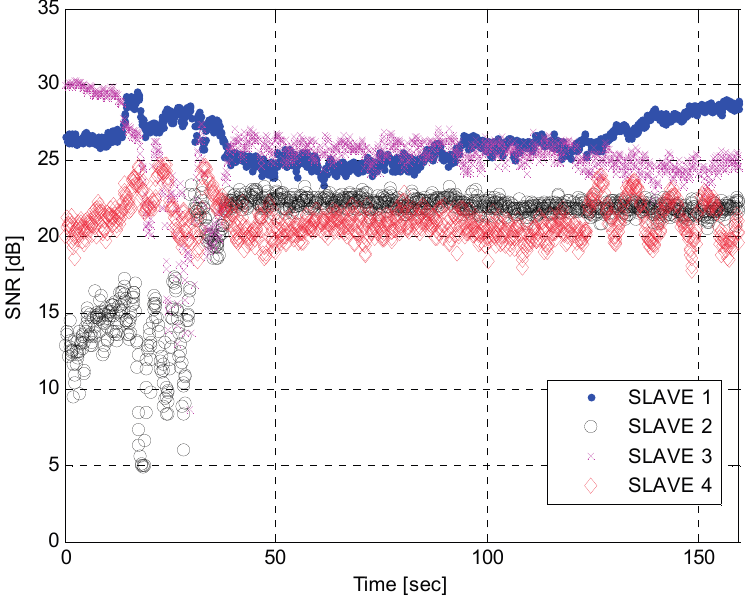
Figure 16. Received signal power transmitted from the slave stations while